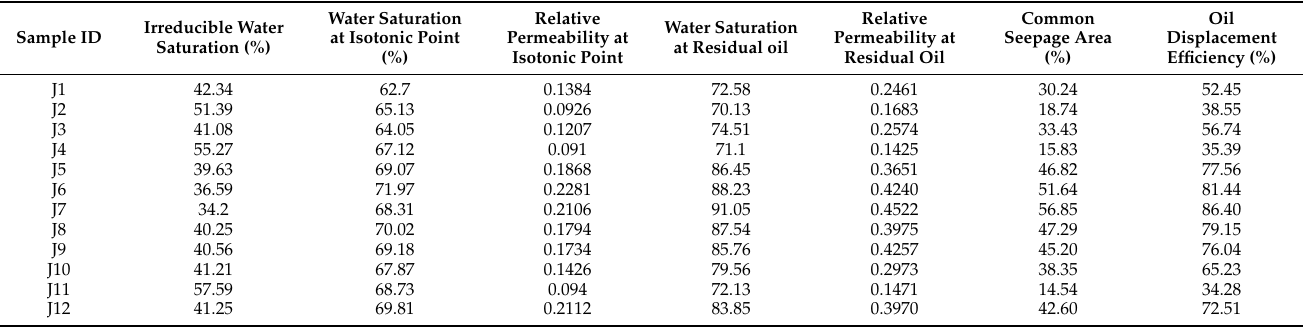
Table 9. The oil–water relative permeability parameters for the 12 typical